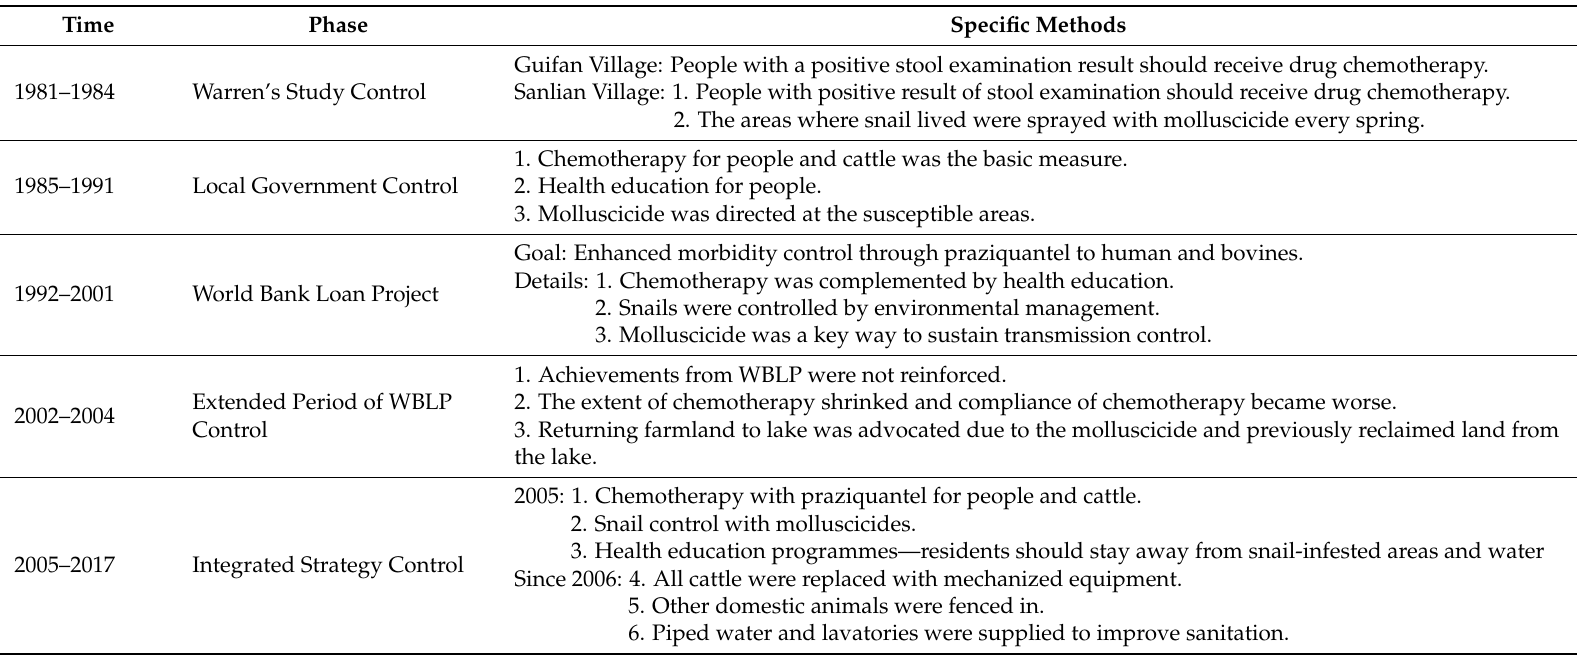
Table 1. The varieties of control strategies of schistosomiasis from 1981–2017 in Guifan and Sanlian villages in